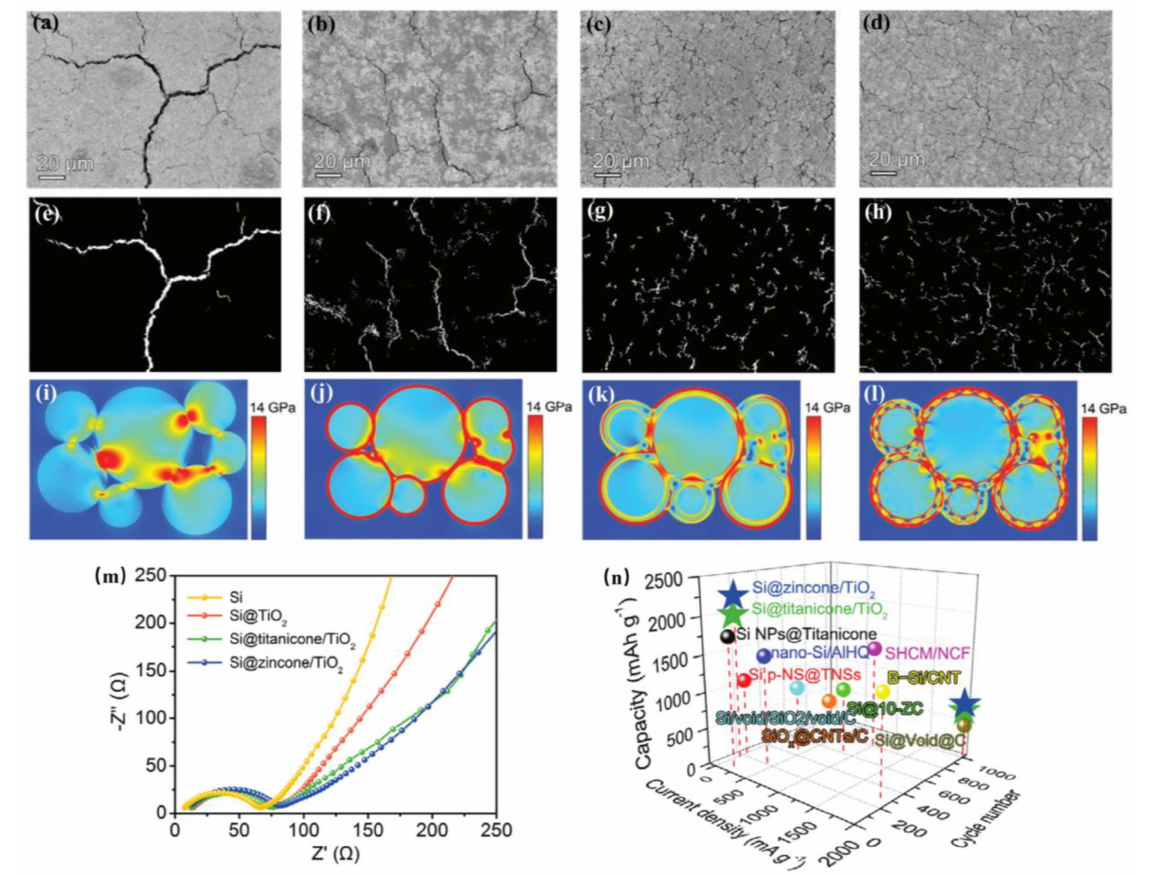
Figure 4. SEM images and the binary images of the cycled electrodes at 0.2 A g − 1 : ( a , e )